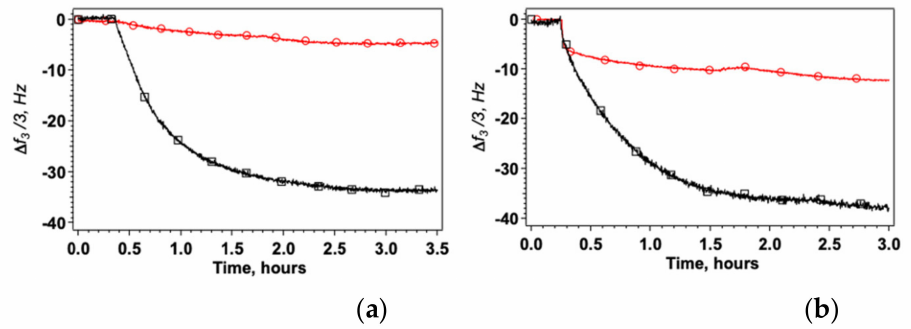
Figure 3. Change of ∆ f 3 /3 after addition of HWL-N ( a ) and HWL-F ( b ) to the nanostructured platform. Bare AgNC/NS arrays: red circles; GO veiled AgNC/NS arrays: black squares. Concentration of lysozyme = 1 × 10 − 6 M in all